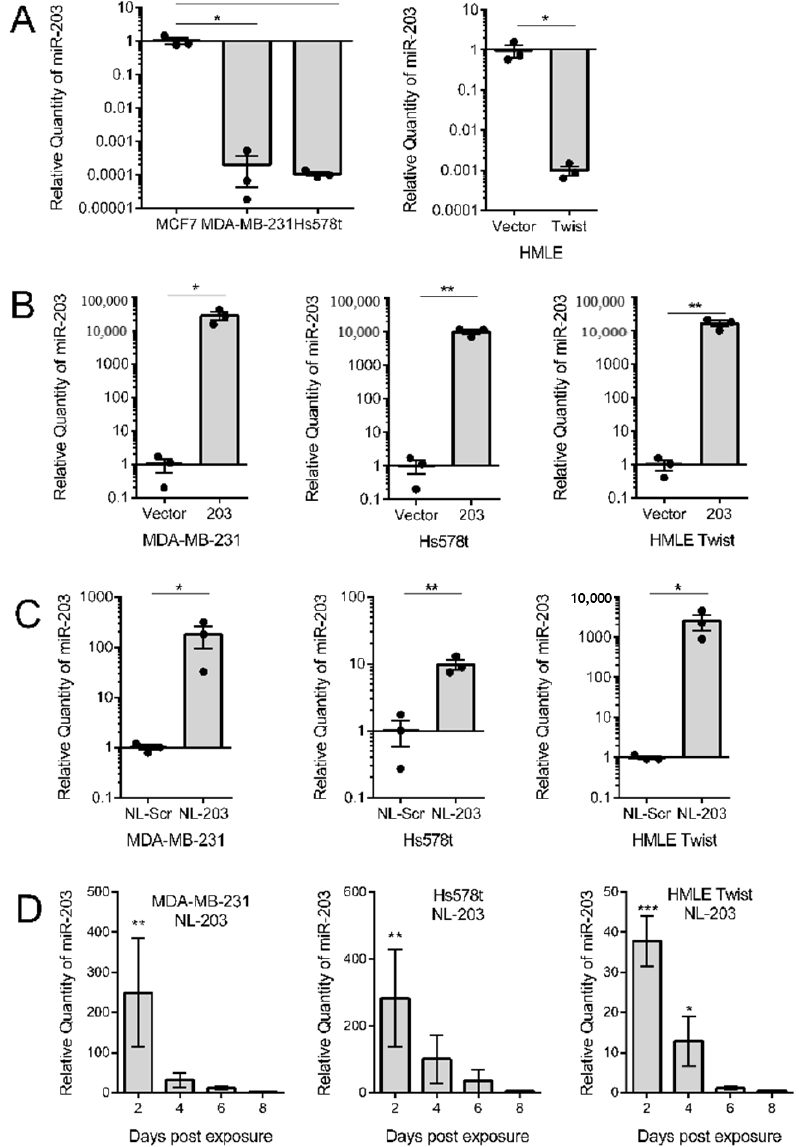
Figure 1. Relative expression of miR-203 performed by miRNA-specific quantitative RT-PCR. ( A ) miR- 203 expression in breast cancer cell lines and in human mammary epithelial (HMLE) cells induced to undergo epithelial–mesenchymal transition (EMT) in response to Twist overexpression. ( B ) miR-203 expression in indicated cell lines transduced with a retrovirus vector to stably overexpress miR-203. ( C ) miR-203 expression in indicated cell lines exposed to microRNA mimic-loaded nanoliposomes at a concentration of 85 µ M for 48 h. Data are presented as the mean and SEM of three independent replicates, two-tailed Student’s t -test. ( D ) miR-203 expression in indicated cell lines for the indicated number of days post-exposure to microRNA-203 mimic-loaded nanoliposomes. Expression is pre- sented relative to control cells exposed to scramble-loaded nanoliposomes. Small nucleolar RNA U6 was used as a normalization control. Data are presented as the mean and SEM of three independent replicates, one-way analysis of variance (ANOVA) with Dunnet’s correction for multiple hypothesis testing. * p < 0.05, ** p < 0.01, *** p <